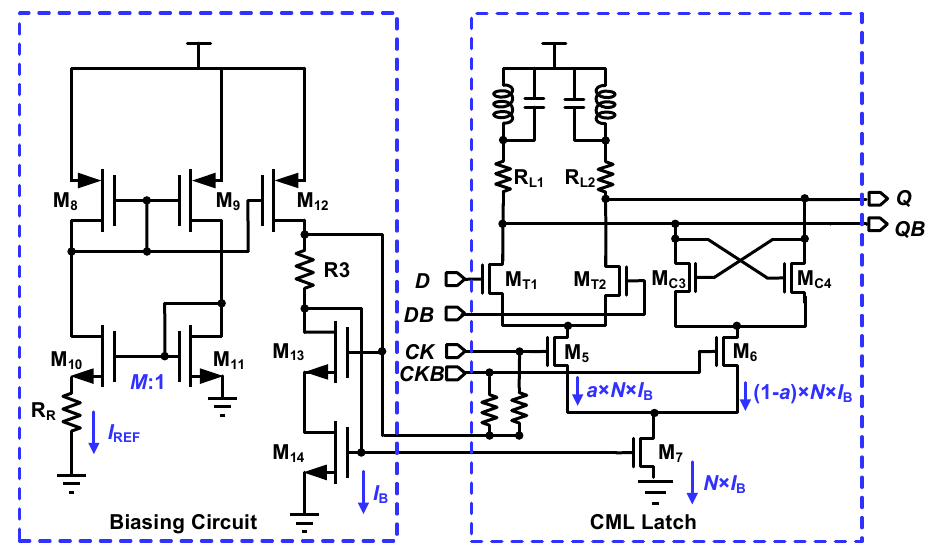
Figure 12. The proposed biasing circuit of the frequency divider.